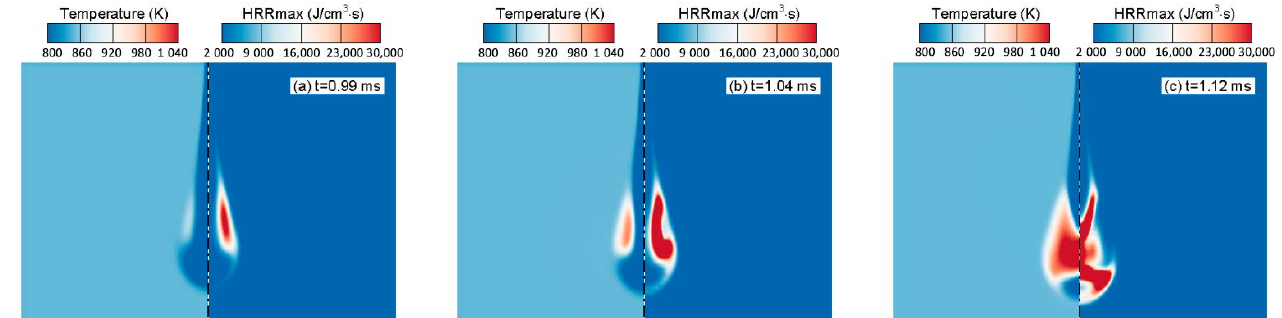
Figure 7. Normalized sensitivity coefficient for CVBs versus shock tubes (initial temperature of 800 K for shock tubes; ambient temperature of 850 K for CVB).